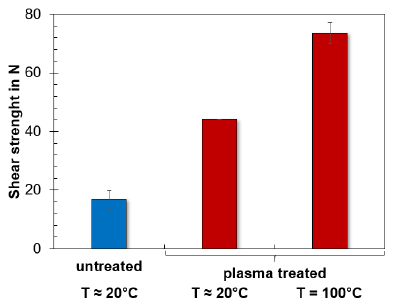
Figure 6. Shear strength of bond surfaces; pure fused silica and fused silica coated with a non- polarising beam splitter coating, without any plasma treatment and after plasma treatment for 30 s and curing at different annealing